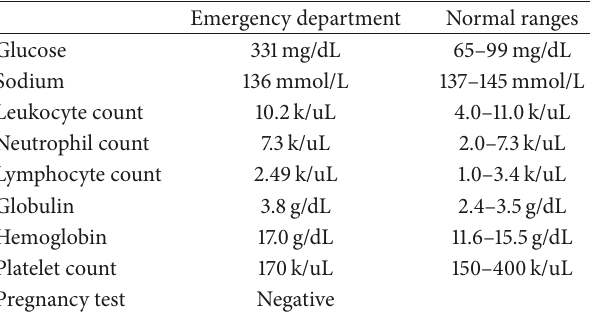
Table 1: Laboratory values for emergency department.